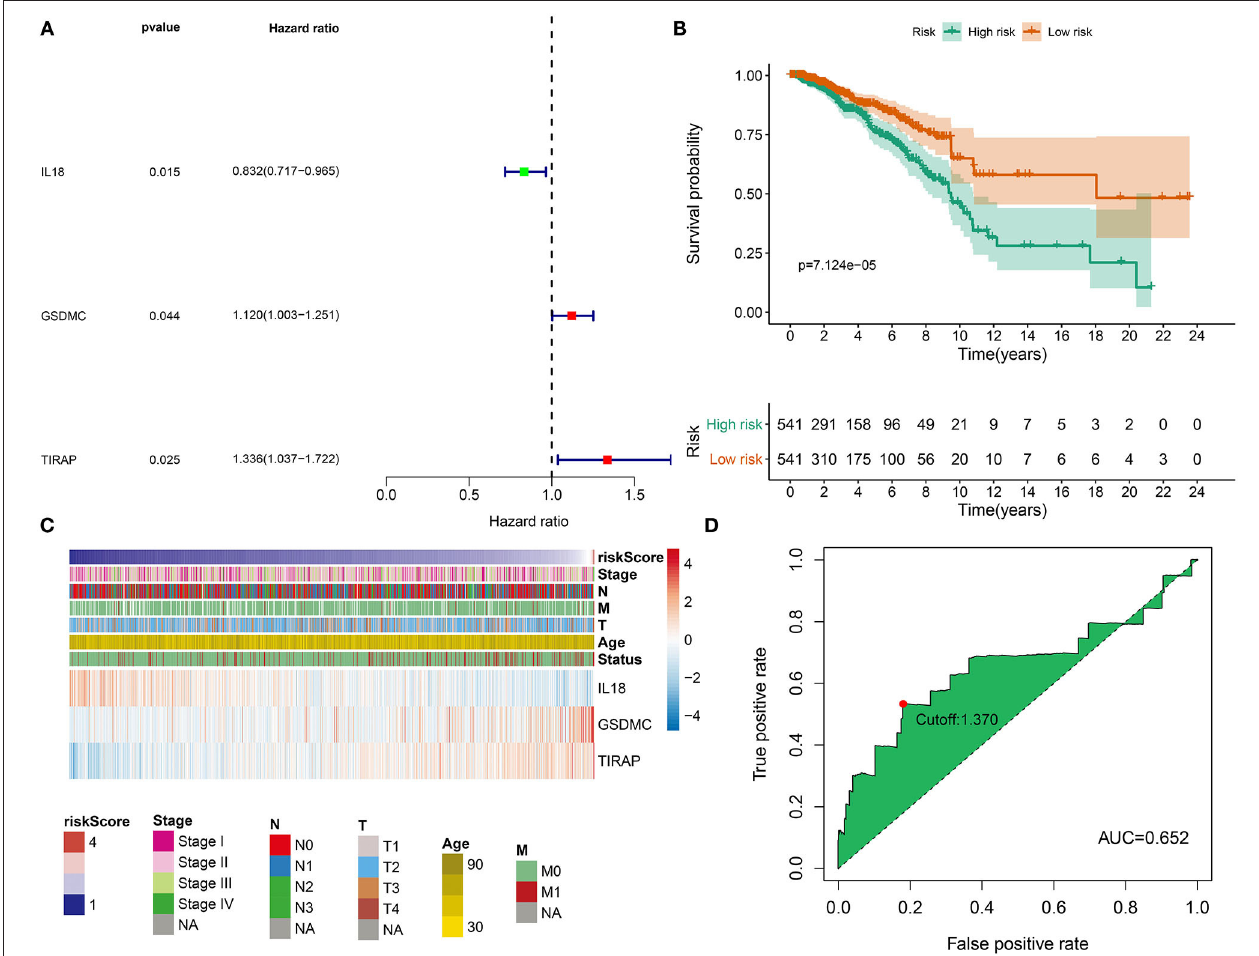
FIGURE 3 | Development of a pyroptosis-related gene signature for breast cancer prognoses. (A) Univariate analyses were utilized for screening prognoses-related pyroptosis genes and a pyroptosis-related gene signature was established. (B) OS probabilities in high- and low-risk patients, followed by log-rank tests. (C) Distributions of IL18, GSDMC , and TIRAP expression in risk scores and different clinical features. (D) ROC curves were plotted for examining the predictive efficacy of this signature.